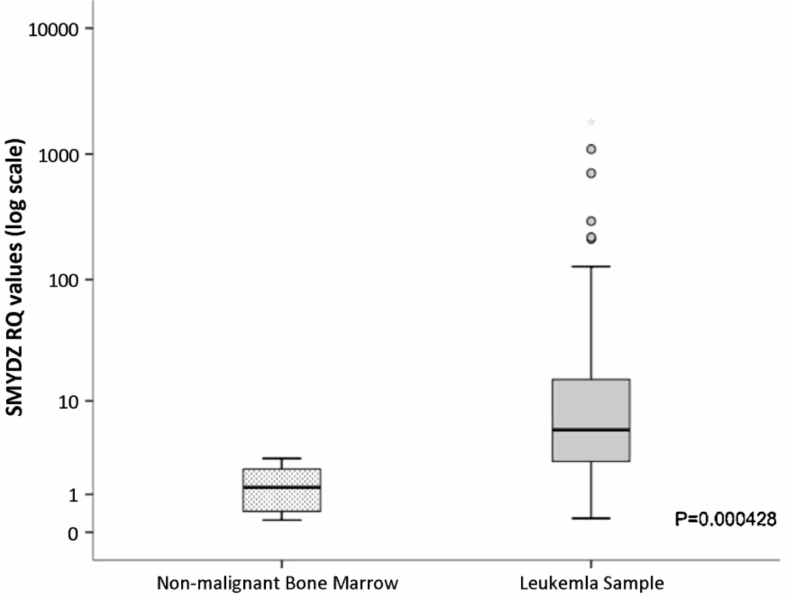
Figure 7. SMYD2 mRNA expression in leukemic bone marrow samples is abnormally high when compared with non-neoplastic samples. Boxplot representation of SMYD2 mRNA expression quantifi- cation by qPCR. mRNA levels were measured in leukemic samples and non-malignant bone marrow. y axis, RQ value for SMYD2 after ACTB normalization. x axis, sample type ( n = 83 for leukemia samples and n = 8 for non-malignant bone marrow samples). Based on the log normal distribution of SMYD2 expression level, five samples represented by circles were defined as outliers according to the outlier labeling rule. Adopted with permission from Ref.